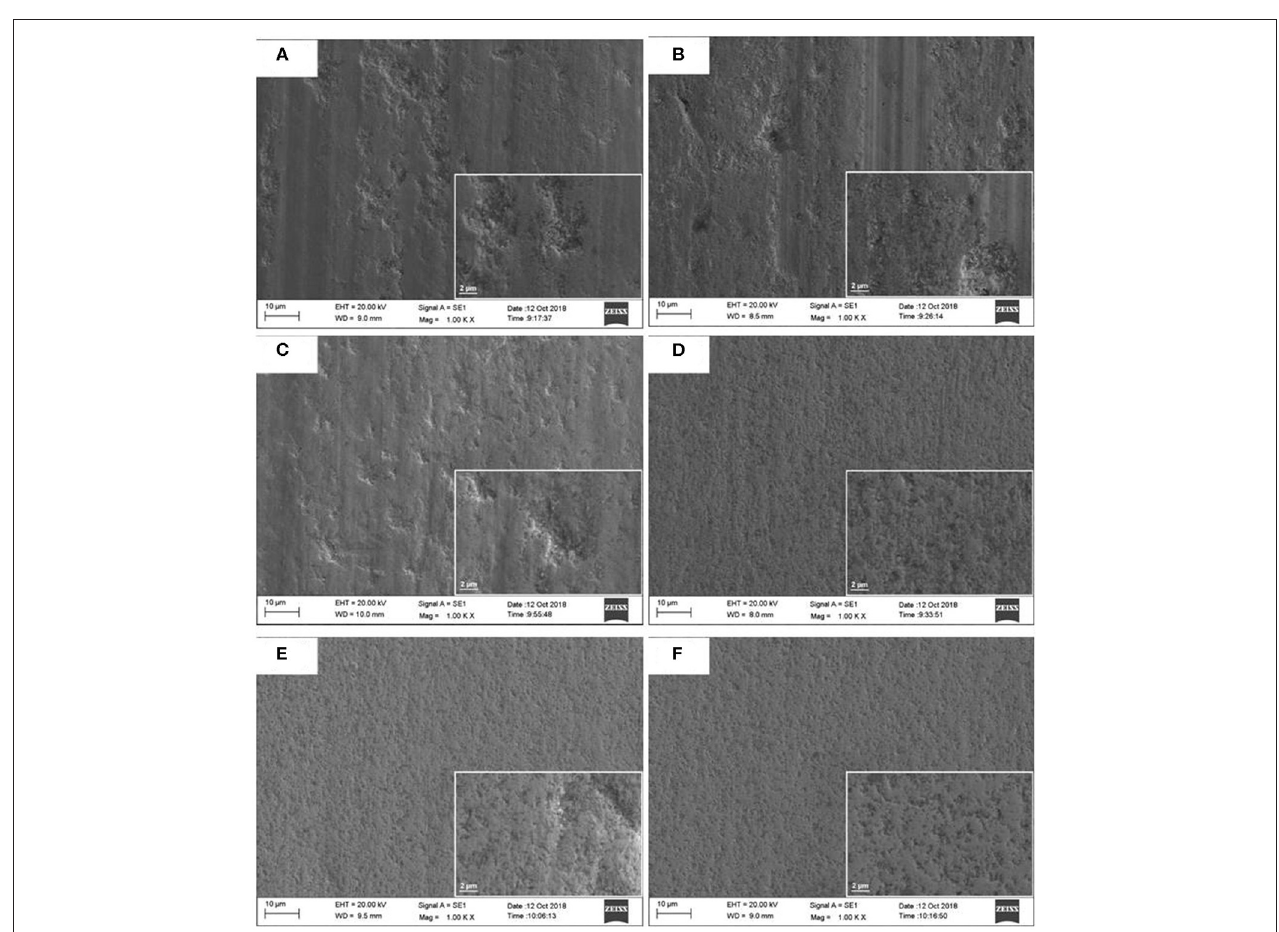
FIGURE 9 | SEM microstructures at low and high magnification of wear areas of the alloys with different Mo 2 C addition amount (on the lower right of the figures are SEM images at 5000 times magnification): (A) 0% Mo 2 C; (B) 1.2% Mo 2 C; (C) 2.4% Mo 2 C; (D) 3.6% Mo 2 C; (E) 4.8% Mo 2 C; (F) 6.0% Mo 2 C.